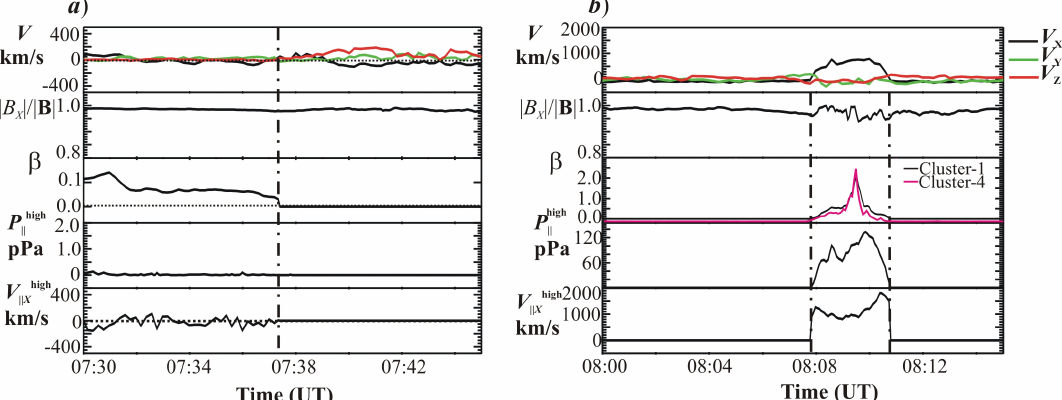
Fig. 3. Zoom of plasma and magnetic field parameters observed by Cluster-1 during intervals of (a) PS-lobe and (b) PSBL crossings on 22 September 2001. From top to bottom: three components of ion velocity (in GSE) calculated for the entire energy range; time profile of | B X | / | B | , plasma β , parallel dynamic pressure P high || and X-component of the ion parallel velocity, calculated for the high energy part of the spectrum ( > 2keV). Additionally in (b) the plasma beta calculated from proton data measured by the CODIF instrument onboard Cluster-4 is shown. The times of crossings of the lobeward boundaries of the PS and the PSBL are shown by the dot-and-dashed lines.